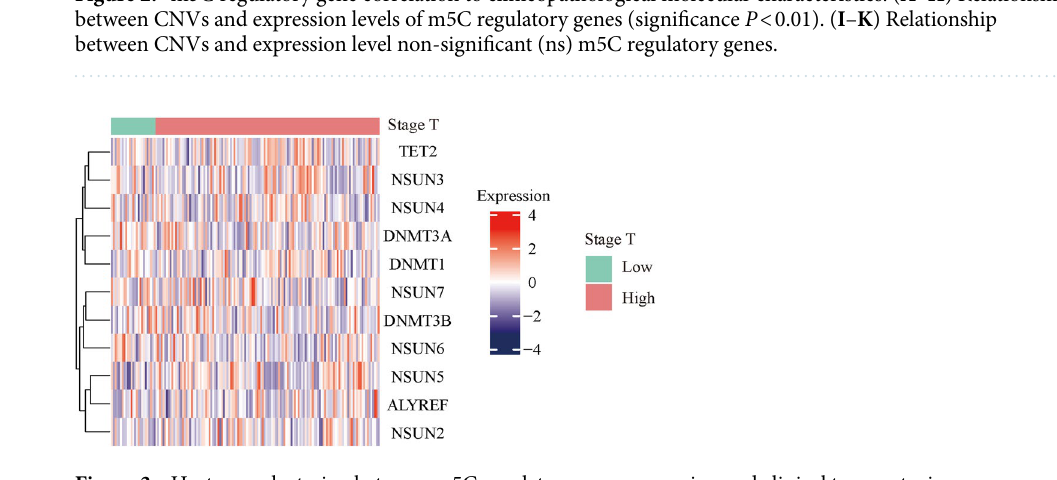
Figure 3. Heat map clustering between m5C regulatory gene expression and clinical tumor